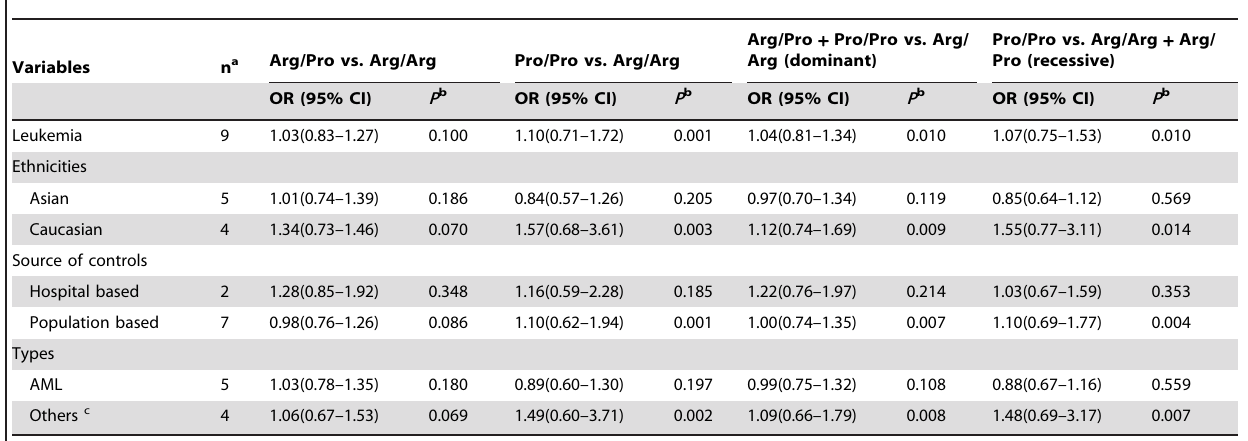
Table 3. Meta-analysis of the p53 codon 72 Arg . Pro polymorphism on leukemia risk.